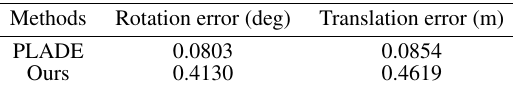
Table 4. Results of two registration methods using the Resso